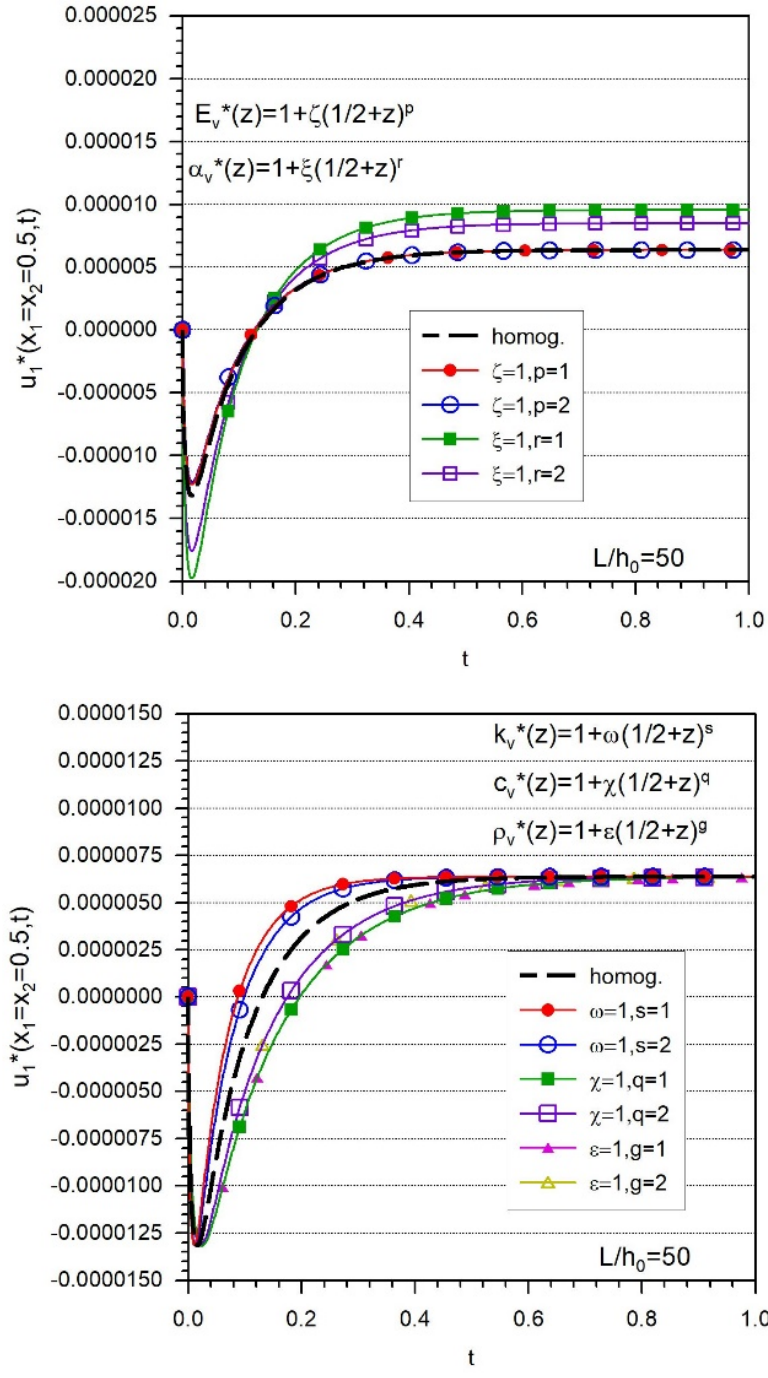
Figure 12. Time variation of the in-plane displacements in homogeneous as well as FGM plates. From Figure 13. it is obvious that the power law gradation of elastic modulus and thermal expansion coefficient plays an important role in the deflection response of FGM thermoelastic plates subjected to transient thermal loadings. It can be seen that the transver- sal gradation of other material properties associated with the heat conduction equation has no influence on the deflection response of the FGM